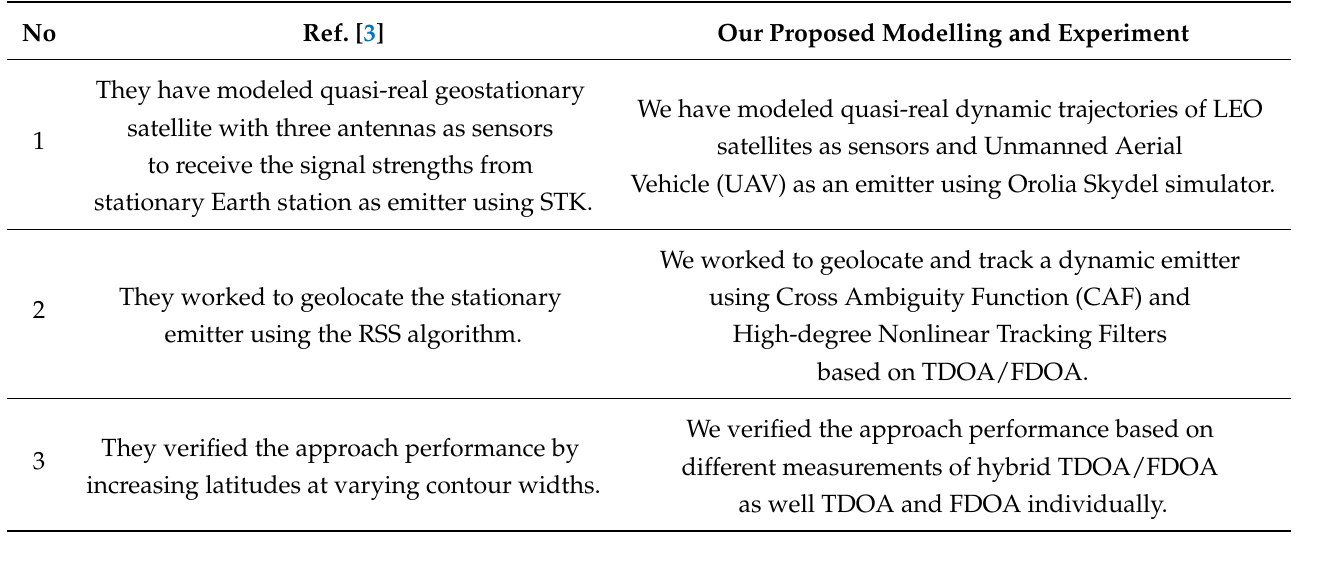
Table 1. Comparison between the modeling and experiment proposed in [3] with our proposed modelling and experiment.